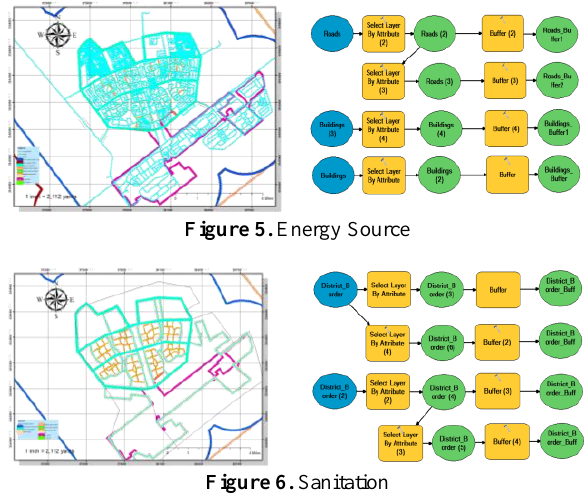
Figure 5. Energy Source